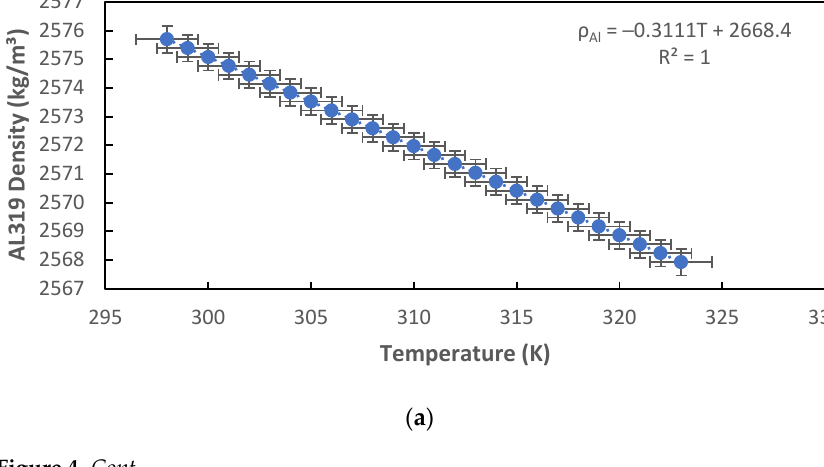
( b ) ( c ) Figure 4. Al 319 relation between material properties and temperature. ( a ) Density, ( b ) Thermal conductivity, and ( c ) Speci fi c heat. The inside of the bo tt le will contain water, so it is also necessary to know the above- mentioned properties of water. The following equations have been used to determine the density, thermal conductivity and speci fi c heat: ρ (cid:2907)(cid:2911)(cid:2930)(cid:2915)(cid:2928) (T) = −0.0046T (cid:2870) + 2.5216T + 656.4 (kg/ 𝑚 (cid:2871) )